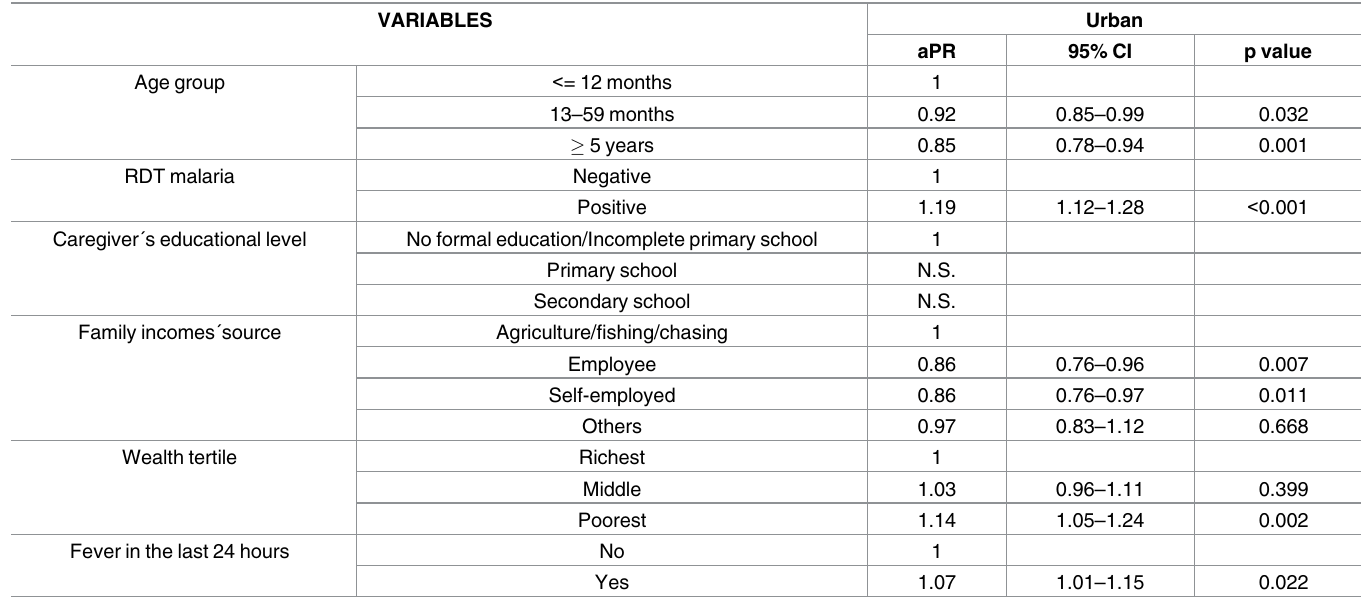
Table 5. Factors associated with anemia in children 2 months-15 years old living in urban settings, Bata district, June-August